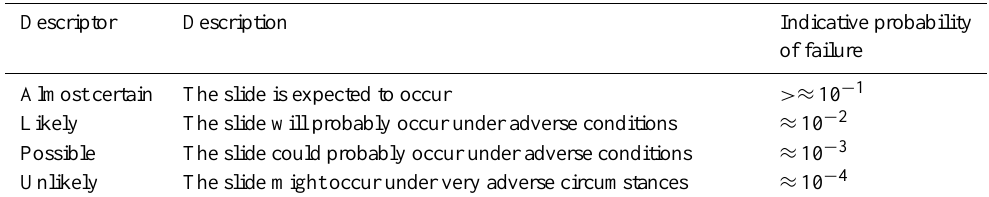
Fig. 11. Categories of possibility of failure of the loose deposits under six 12-h rainfall scenarios ( a : under 5mm/12h rainfall; b : under 15mm/12h rainfall; c : under 30mm/12h rainfall; d : under 70mm/12h rainfall; e : under 140mm/12h rainfall; f : under 240mm/12h rainfall). Qualitative measures of likelihood (modified from Australian Geomechanics Society Sub-Committee on Landslide Risk Management,